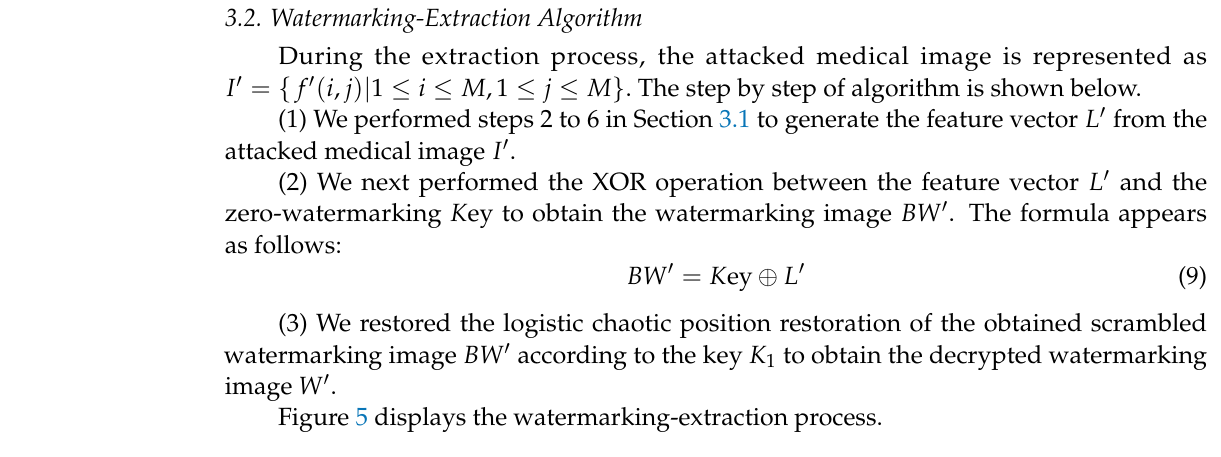
Figure 4. Watermarking-embedding flowchart.